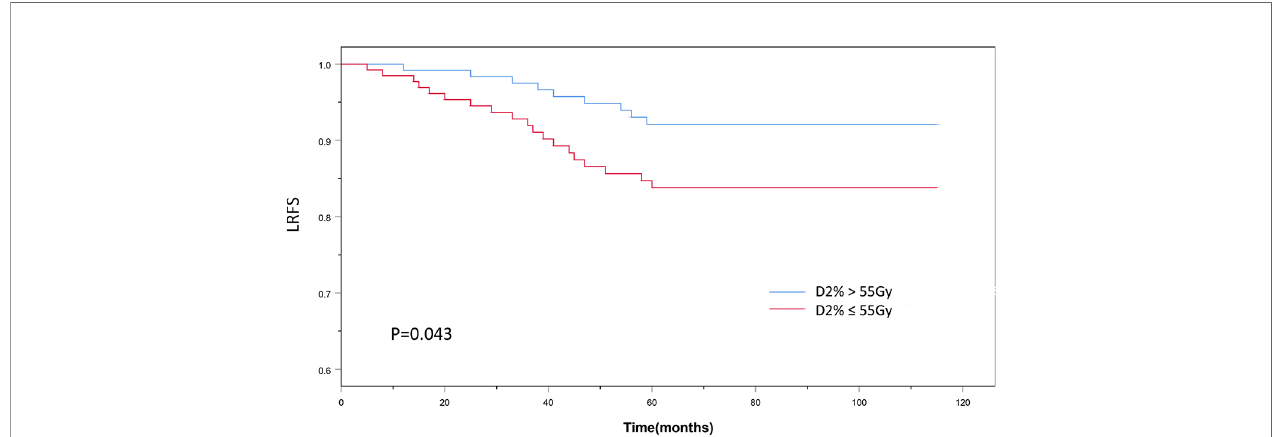
FIGURE 3 | The 5-year local recurrence-free survival outcomes of D2% >55Gy and D2% ≤ 55 Gy groups treated with intensity-modulated radiotherapy. P < 0.05 was considered statistically signi fi cant.